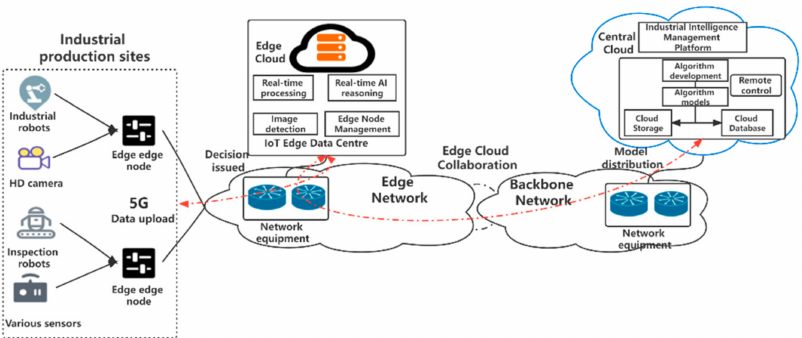
Figure 4. Diagram of an industrial EC-IoT